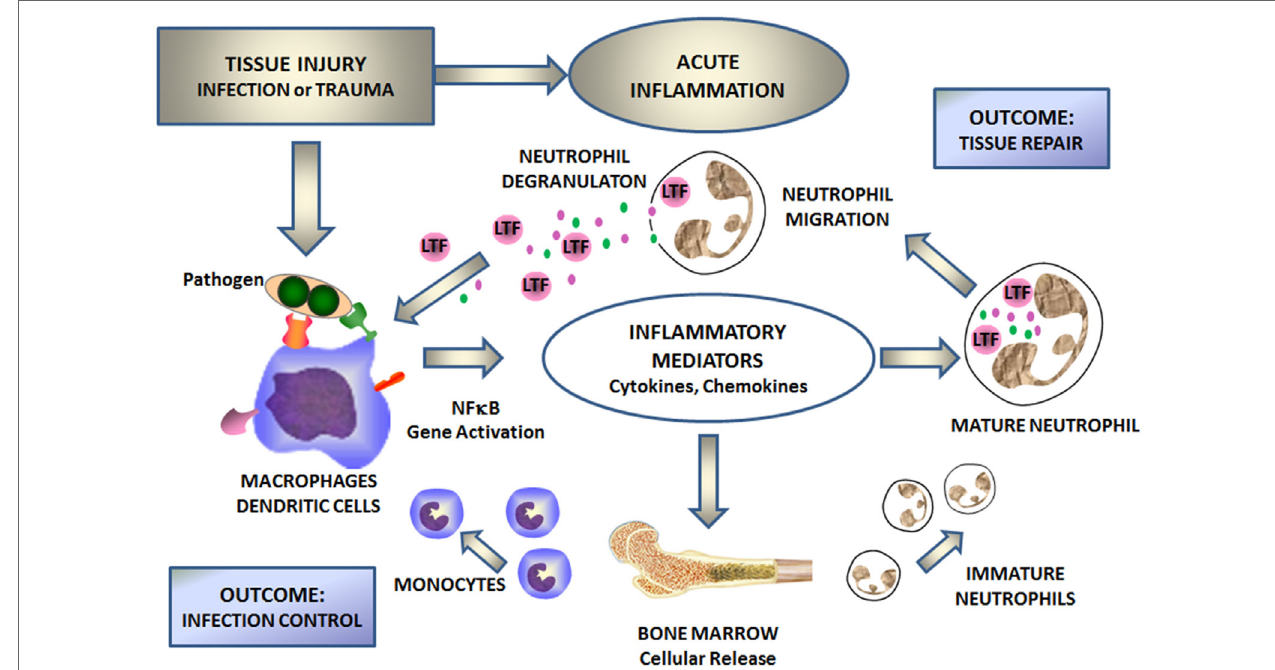
FigURe 1 | Lactoferrin (LTF) mediates cellular responses to environmental insults. Injury defined by infection, or trauma leads to activation of the NF- κ B signal transduction pathway within monocyte/macrophages and/or dendritic cells. This in turn stimulates the production of inflammatory mediators, which subsequently stimulates the production of fresh neutrophils and monocytes from bone marrow and activates circulating neutrophils. Activated neutrophils degranulate to release secondary mediators, including LTF. By interacting with specific receptors on monocytes/macrophages and other immune and non-immune cells, LTF attenuates inflammation and contributes to tissue repair and limits spread of infectious